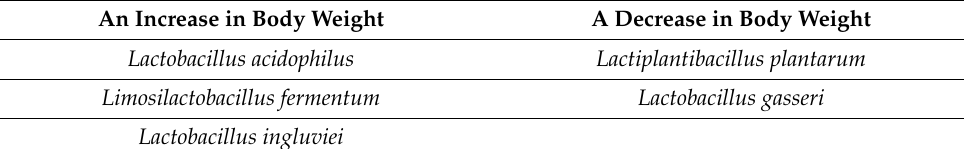
Table 1. The results of the meta-analysis of Million et al. [33].